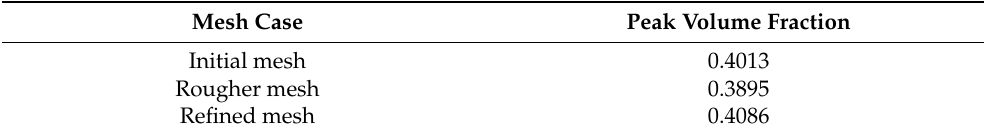
Table 3. Peak volume fraction for each case.